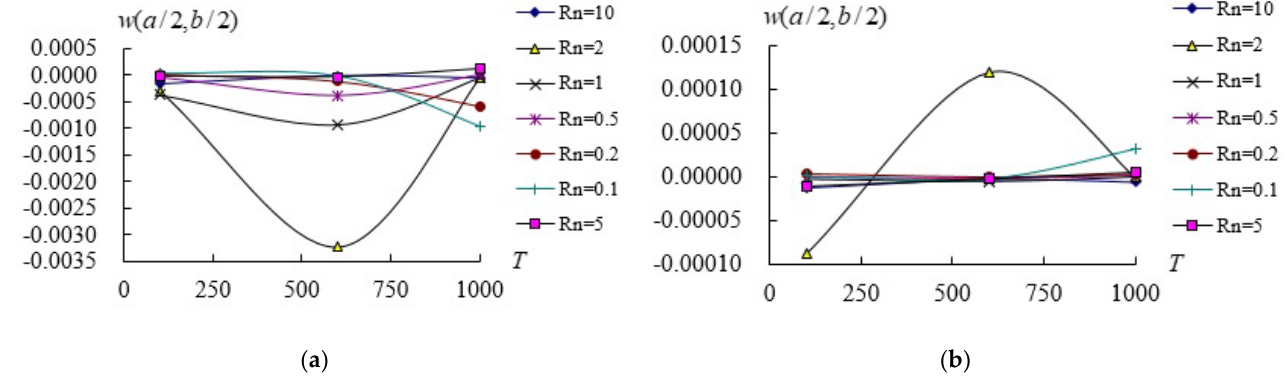
Figure 4. (unit mm) vs. T (unit K): ( a ) for Figure 4. w ( a /2, b /2 ) (unit mm) vs. T (unit K): ( a ) for a / h ∗ = 5; ( b ) for a / h ∗ = 10. Figure 4.